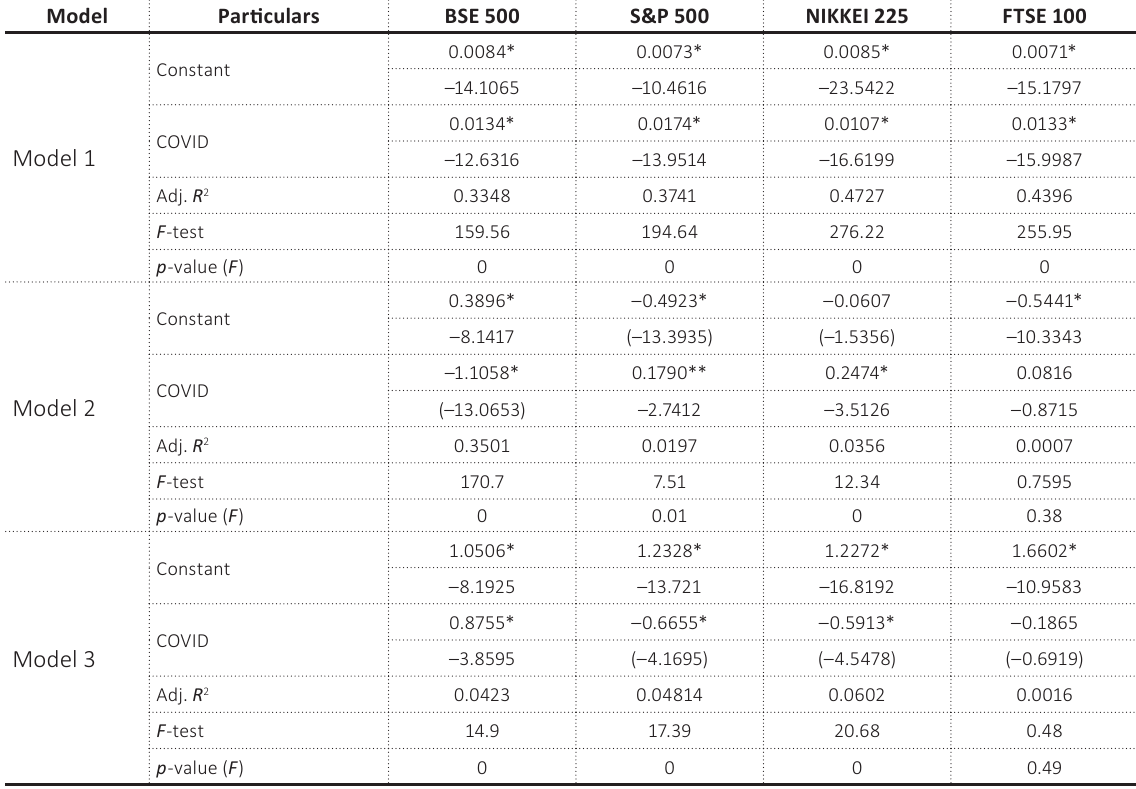
Table 7. Regression analysis – comparing BSE 500 with global market indices (Model 1 – Model 3)